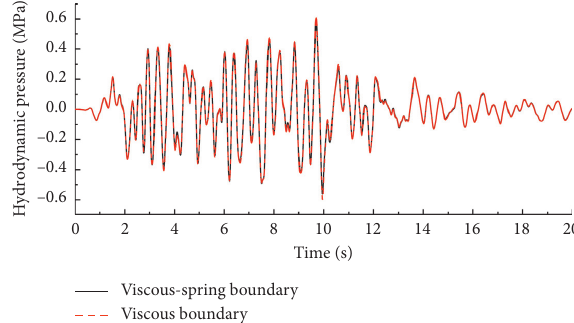
Figure 20: Time histories of hydrodynamic pressure of the Jin’anqiao dam at dam heel.